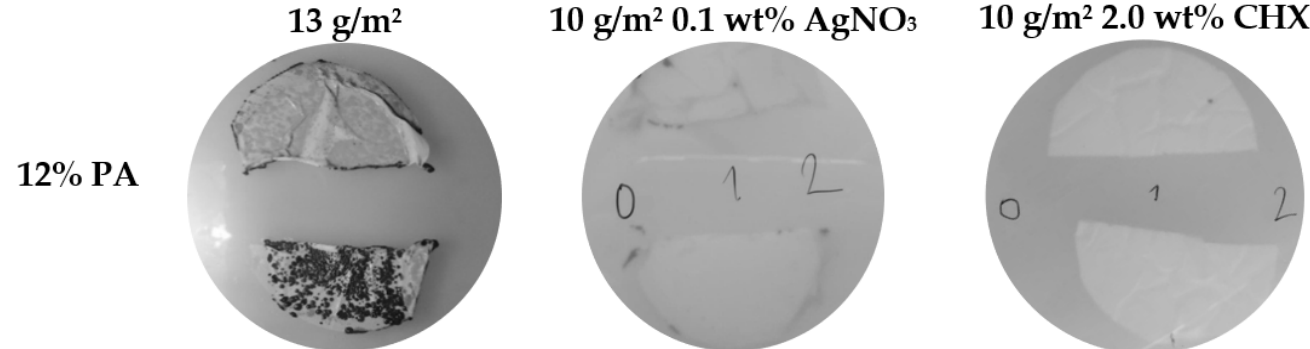
Figure 4. Examples of PAs cultivated at BP agar after the filtration of S. aureus CCM 4516; half of the PA at the top corresponds to the bottom side through which the suspension was not filtered, and half of the PA at the bottom corresponds to filtration side. The numbers (0, 1, 2, etc.) denote individual decimal dilutions of the final filtrates.